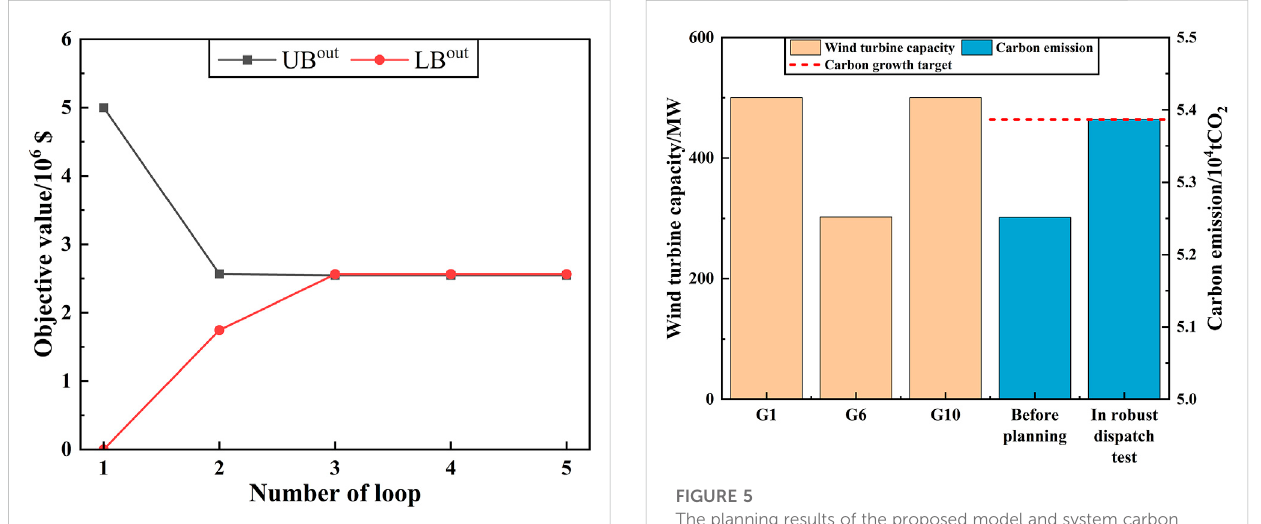
FIGURE 4 The convergence process of the proposed model.